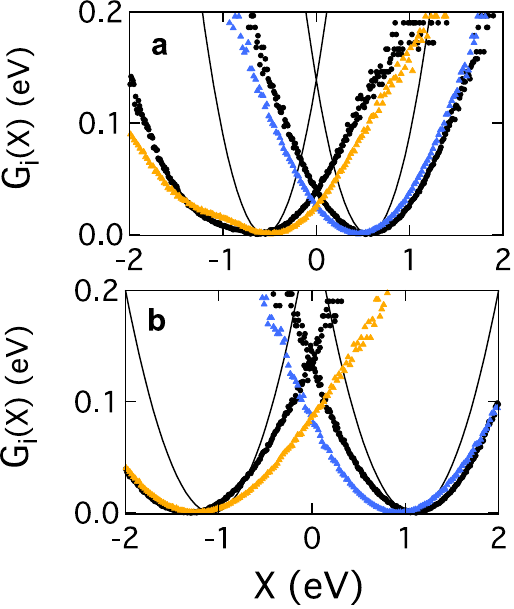
Figure 3. Free energy surfaces. G i ( X ) for electron transfer for N4 − → N5 ( a ) and N5 − → N6a ( b ). The grey solid lines show the results from the Marcus theory (equation 1) based on λ St from classical MD simulations. The black dots are direct calculations of G i ( X ) from classical MD trajectories. The QM/MD results are shown by the blue points for the forward transition (e.g., N4 − → N5) and by the orange points for the backward transition (e.g., N5 − → N4).